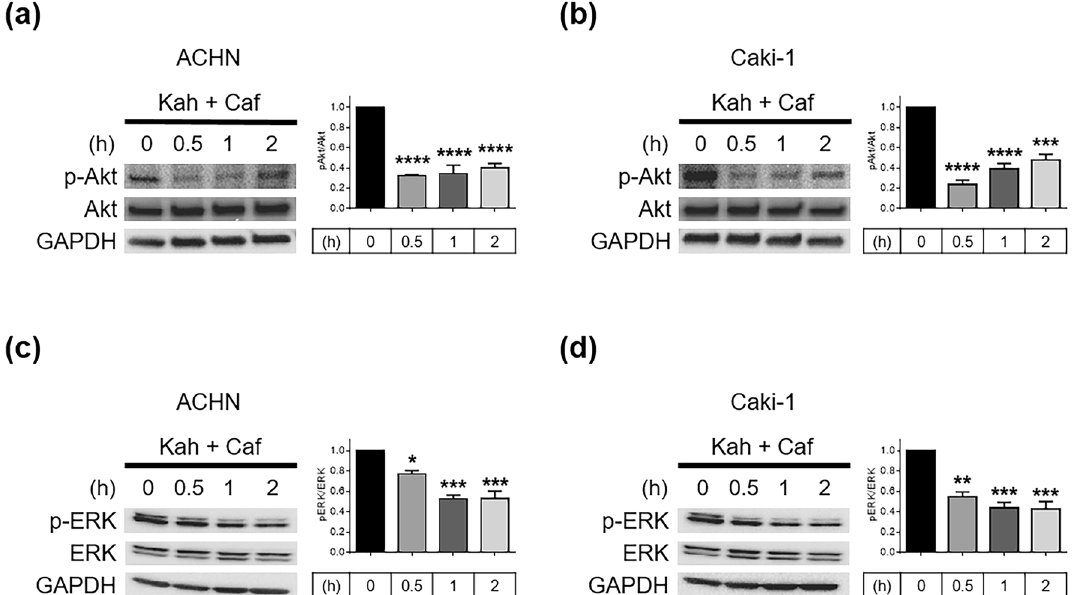
Figure 4. The combination of 30 µM kahweol acetate and 30 µM cafestol inhibited Akt and ERK signaling in renal cancer cells. ( a – d ) Phosphorylation of Akt in ACHN ( a ) and Caki-1 ( b ) cells, phosphorylation of ERK in ACHN ( c ) and Caki-1 ( d ) cells, at the indicated times after combination treatment were assessed using Western blot analysis and quantitatively analyzed using densitometry with ImageJ software as shown by bar graphs. Equal amounts of cell lysates (10 µg) were subjected to electrophoresis. Data are presented as means ± standard error of the mean (n = 3). * p < 0.05; ** p < 0.01; *** p < 0.001; **** p <